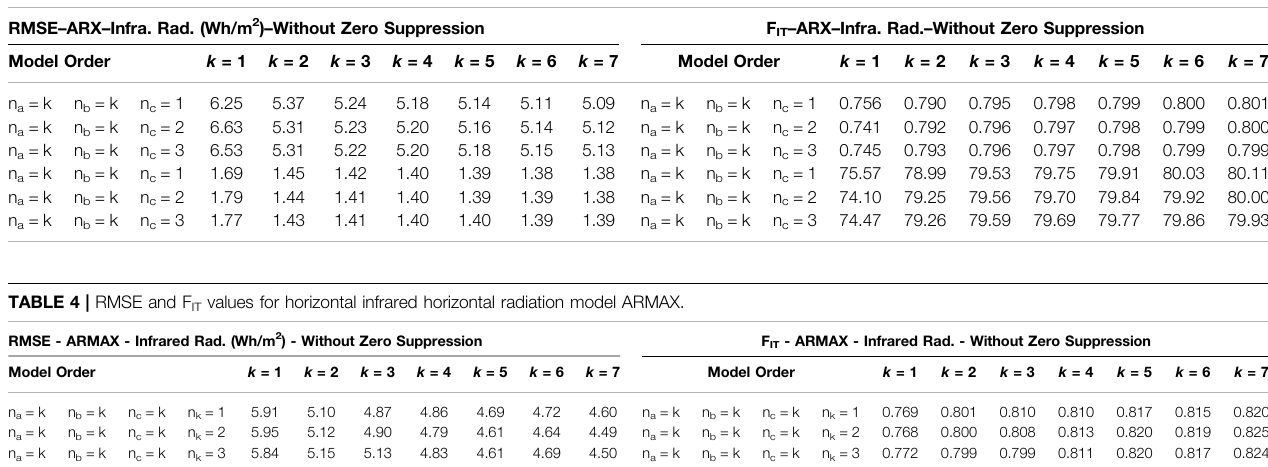
Each model generates 32,496 hourly radiation values, but graphs with 100-h samples were presented in order to facilitate comparison of the original data with that generated by the models. In order to provide a notion of the dimension of the data, Figure 2 shows a graph of 1000 h with all the data.